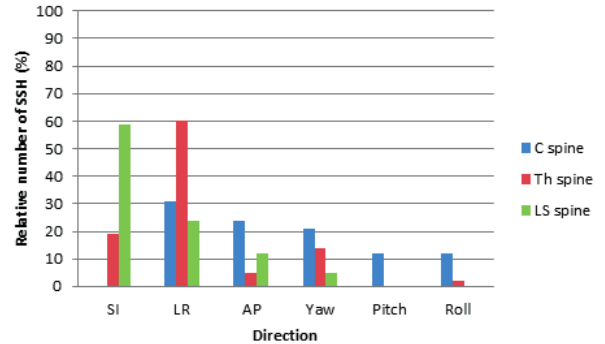
Fig. 3. The relative occurrence (%) of spine significant shifts (SSHs) in translational and rotational directions for the cervical (C), thoracic (Th), and lumbar-sacral (LS) regions of the spine.